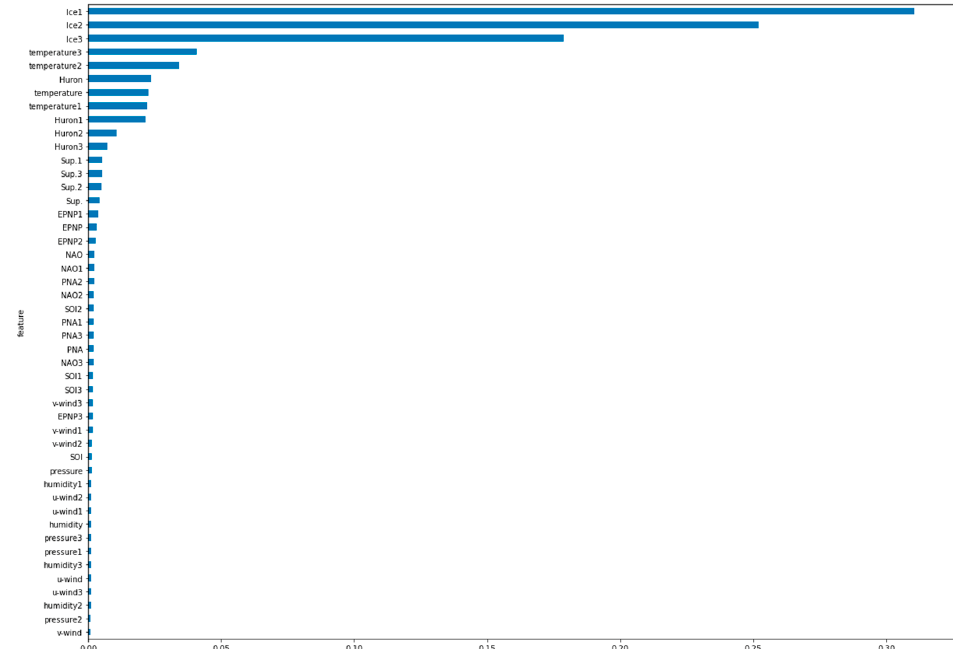
Figure 5. Feature significance for XGBoost. A number after a variable name indicates a leading day(s). For example, Ice1 , Ice2 , Ice3 are features that indicate ice coverage over the river system 1 day, 2 days, and 3 days prior, respectively. temperature indicates 2 m air temperature. Huron and Sup indicate lake-wide-averaged water surface temperature in Lake Huron and Lake Superior, respectively.